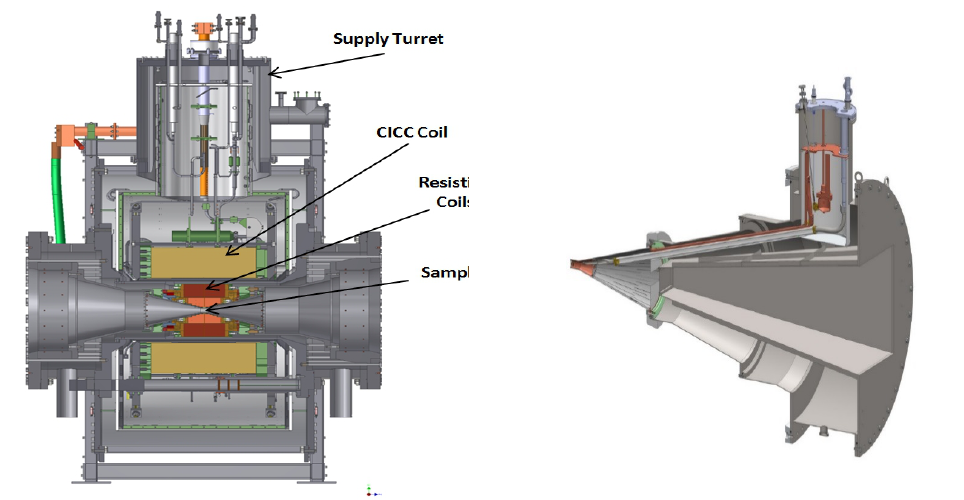
a) Cross-section through HFM showing the superconducting CICC coil and resistive insert coils. The cryogenic and electrical utilities enter through the upper supply